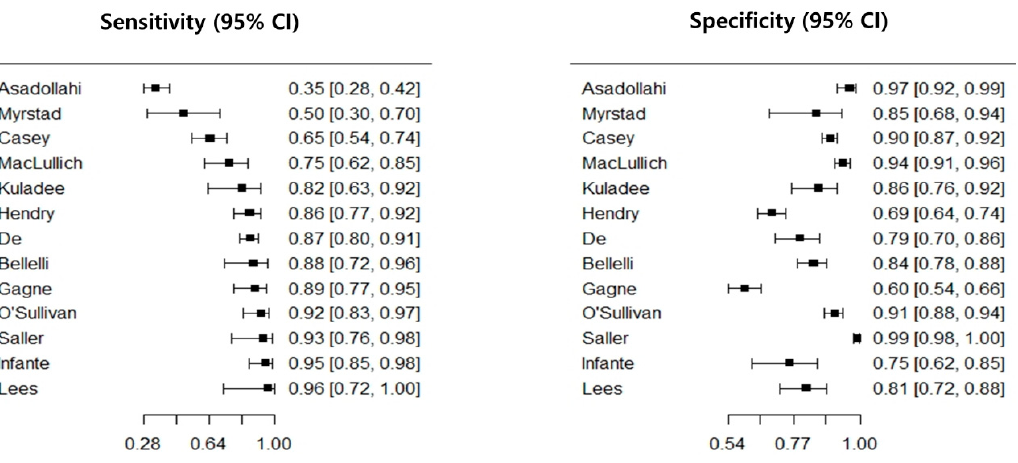
Figure 2. Coupled forest plot of the 4AT. CI, confidence interval; 4AT, 4 ‘A’s Test.